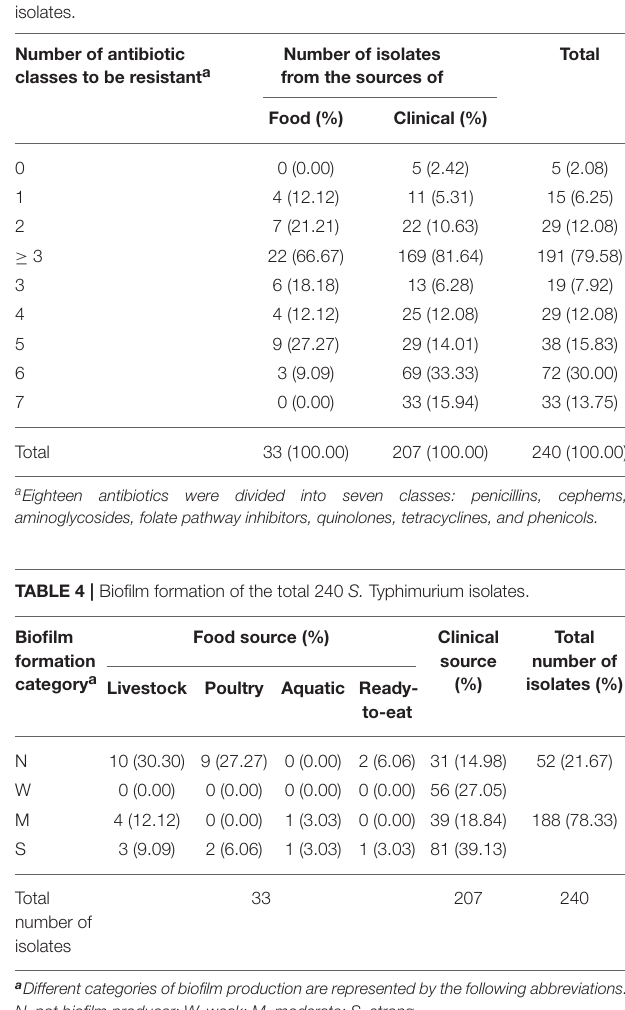
Number of isolates from the sources of